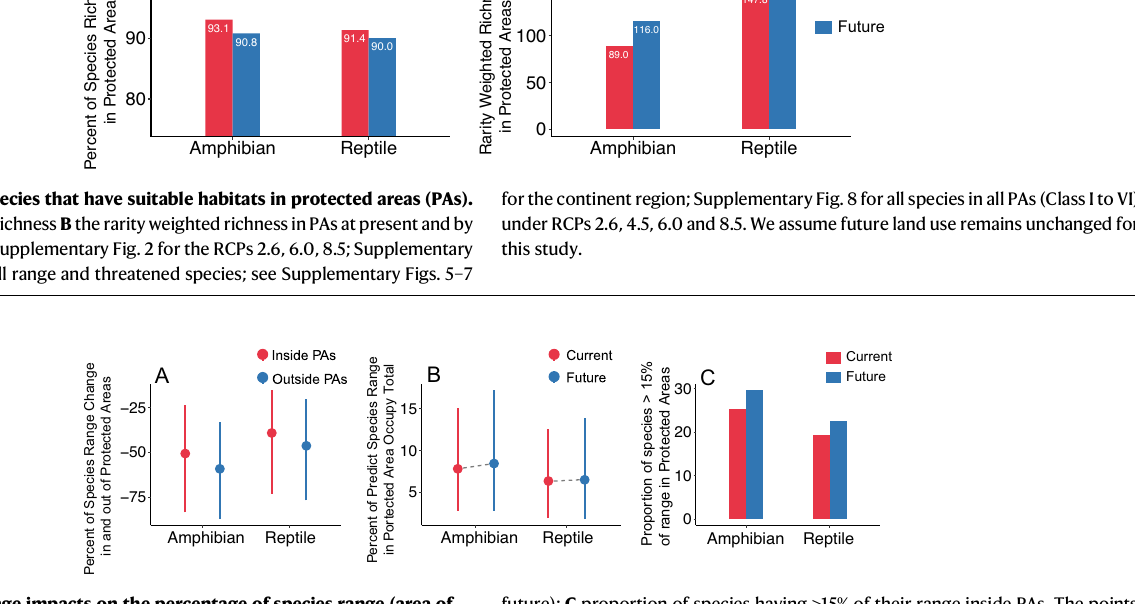
future); C proportion of species having >15% of their range inside PAs. The points and error bars in(A) and (B) represent the medians and the 25%and 75%quantiles. See Supplementary Fig. 8 for the RCPs 2.6, 6.0, 8.5; Supplementary Figs. 9 and 10 for small range and threatened species; see Supplementary Figs. 11 – 13 for the continent region. We assume future land use remains unchanged for this study.